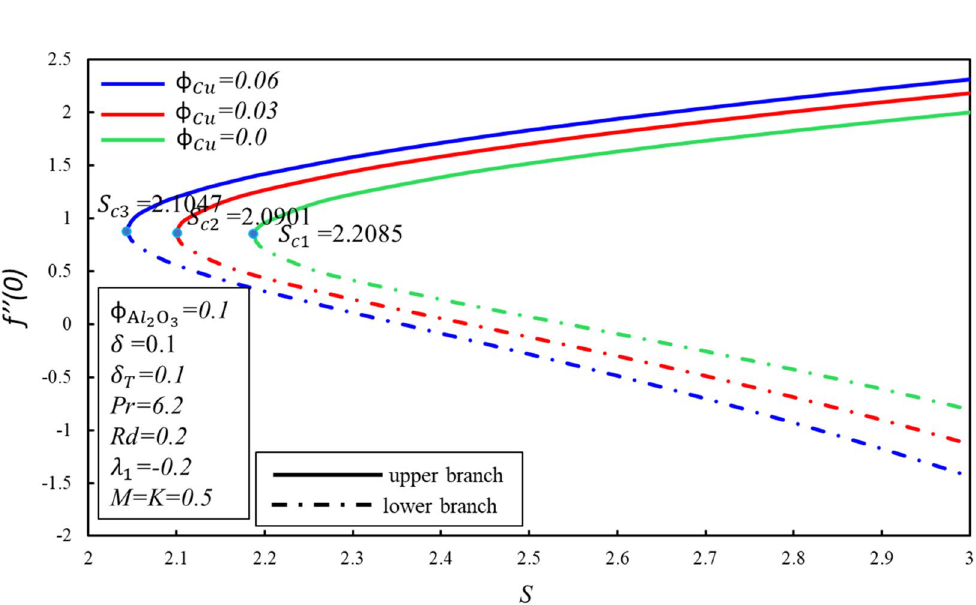
Table 4. Values of f ′′ ( 0 ) for the various values of φ Cu by keeping φ Al 2 O 3 3 . S =